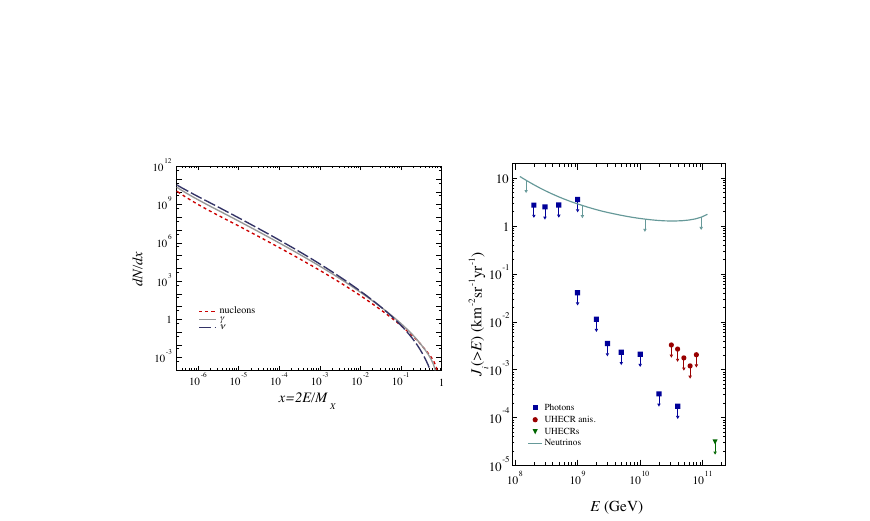
Figure3. Upperlimitsonsecondariesproducedfromthedecayof SHDMparticles. Figure 1. [Left Panel] Distribution function of the SM products in the SHDM decay. [Right Panel] Auger experimental limits on the fluxes of gamma rays and neutrinos. Figures taken from [5].